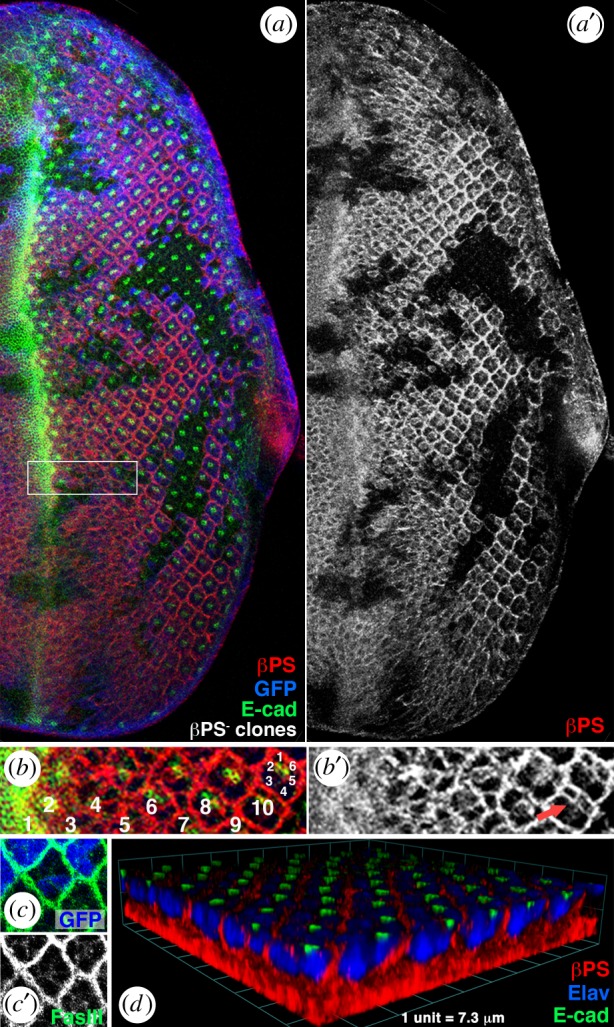
Localization of Mys/βPS–integrin during eye disc patterning. All panels show confocal images of third instar eye discs. Anterior is left and dorsal is up. Integrin βPS subunit, visualized by a specific antibody (red in a–c, and single channel in a′, b′ and c″), is highly enriched at membranes that are at the periphery of the developing ommatidial clusters, basal to adherens junctions (marked by DE-cadherin, green in a, b and d), and on the basal sides of each cell. (a–c) mys1 clones (mutant for βPS–integrin subunit) are marked by the absence of GFP (blue in a and c, single channel in c′). (b) Enlargement of boxed area in (a). Approximately 9–11 columns posterior to the morphogenetic furrow, βPS/Mys is also detected around the cells of the R1/R6 pair (red arrow in b′). Numbers 1–10 mark the respective columns posterior to MF, the respective R cells are labelled with small white numbers (1–6) in most posterior cluster shown. See electronic supplementary material, figure S4 for more on R1/R6 expression. (c,c′) The loss of βPS/Mys does not cause apical–basal polarity defects, nor does it affect precluster integrity in third instar eye discs, as apical markers (DE-cadherin, green in a) and markers for the basolateral plasma membrane (FasIII, green in c; single channel in c′) are unaffected. (d) Three-dimensional rendering of confocal stacks showing the βPS/Mys localization (red) baso-laterally, having a ‘basket’-like appearance around each cluster. Photoreceptor nuclei are marked with anti-Elav (blue) and DE-cadherin (green) marks the apical adherens junctions.